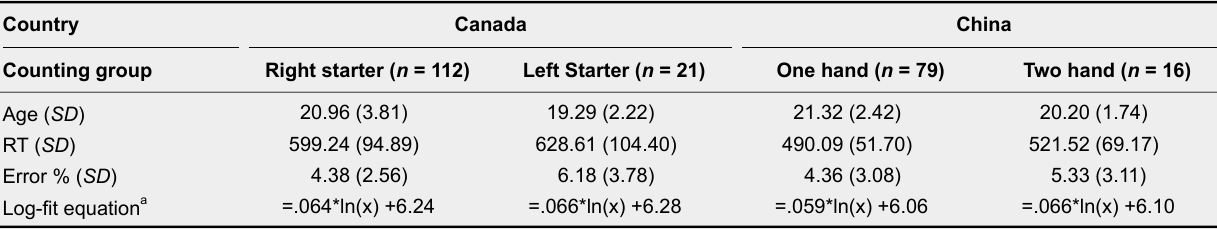
Descriptive Statistics for the Four Finger-Counting Groups